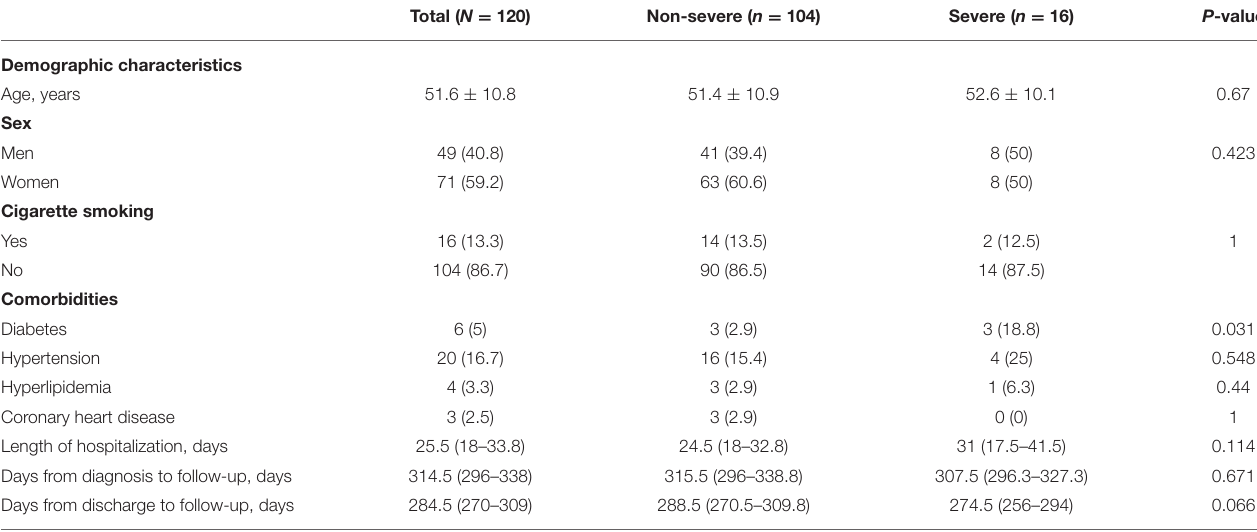
TABLE 1 | Demographic and clinical characteristics of the enrolled COVID-19